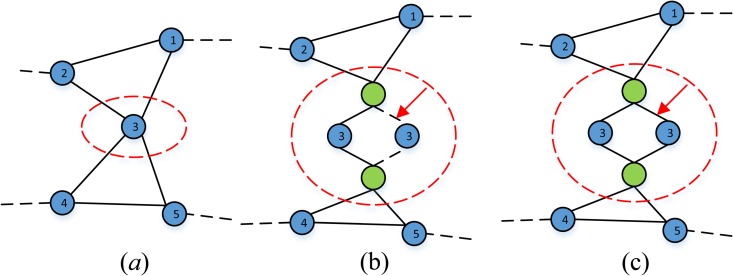
Nodes back-up model.